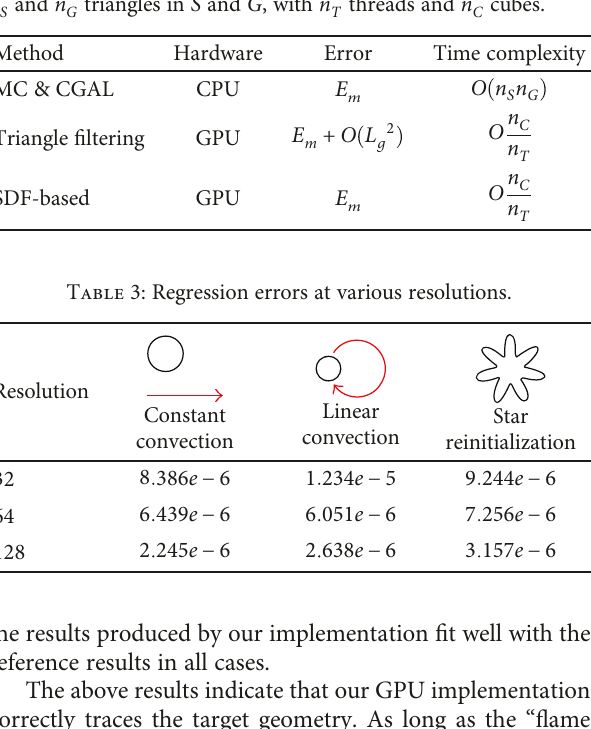
Table 2: Complexity and accuracy of various Boolean operations: and n triangles in S and G , with n n S G